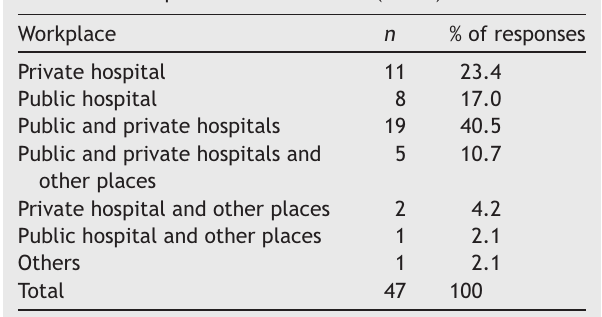
Workplace of interviewees ( n = 47).